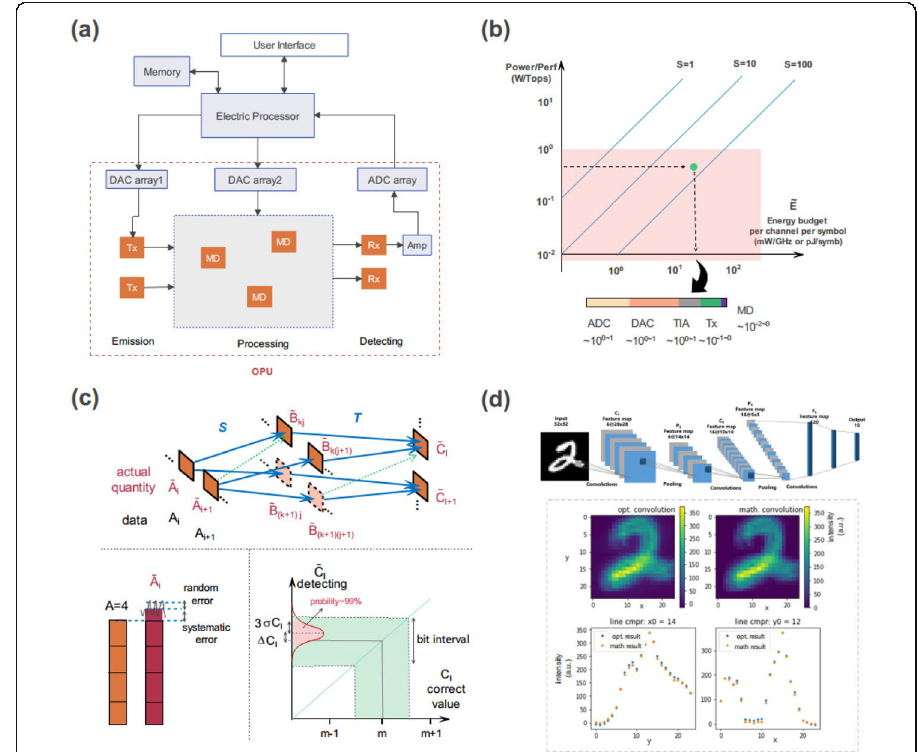
Fig. 6 Overview of optical-electrical hybrid computing system. a Schematic diagram of architecture for the optical-electronic hybrid system. b Ratio of power cost to performance. S is the speed-up factor in Eq. (6). ~ E represents energy budget per channel per symbol. The bar chart below represents a typical energy-per- symbol distribution. c Schematic illustrations for finite precision analysis in OPU. The upper panel shows the propagation routes of data in a VMM, with the blue solid arrow line and the green dash arrow line indicating correct and crosstalk routes respectively. The bottom left panel shows the deviation between actual physical quantity and ideal data. The bottom right panel depicts the relationship of accumulated error and bit precision in computing. d Convolution result of OPU with equivalent 4bit output